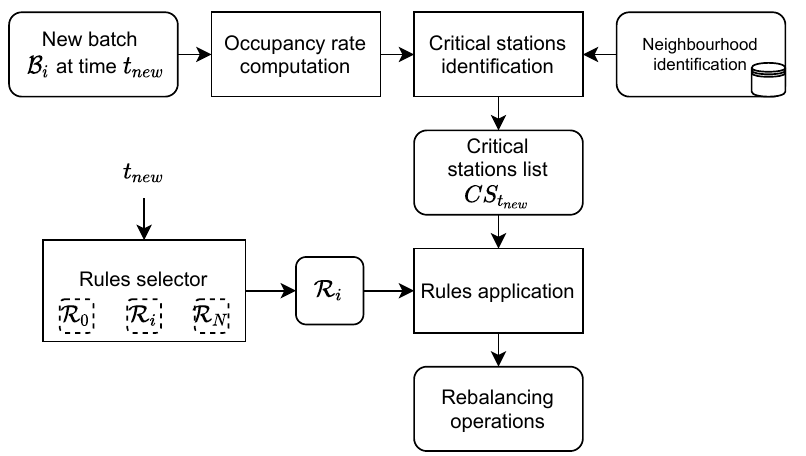
Figure 3. Framework’s structure when the system is